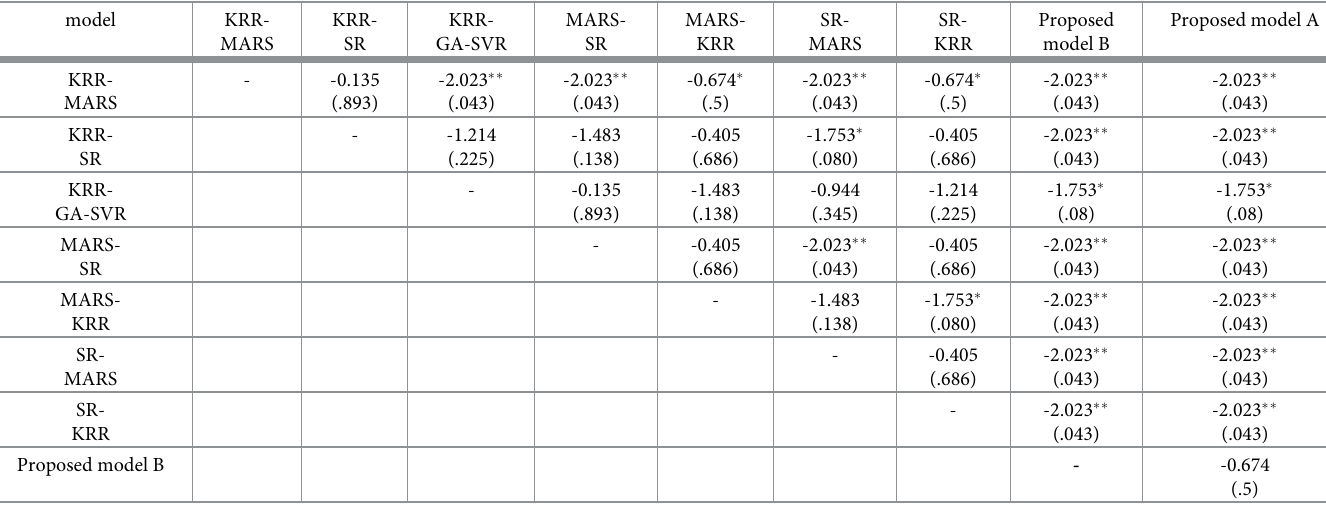
Table 13. Wilcoxon sign test for different models comparison in short period.